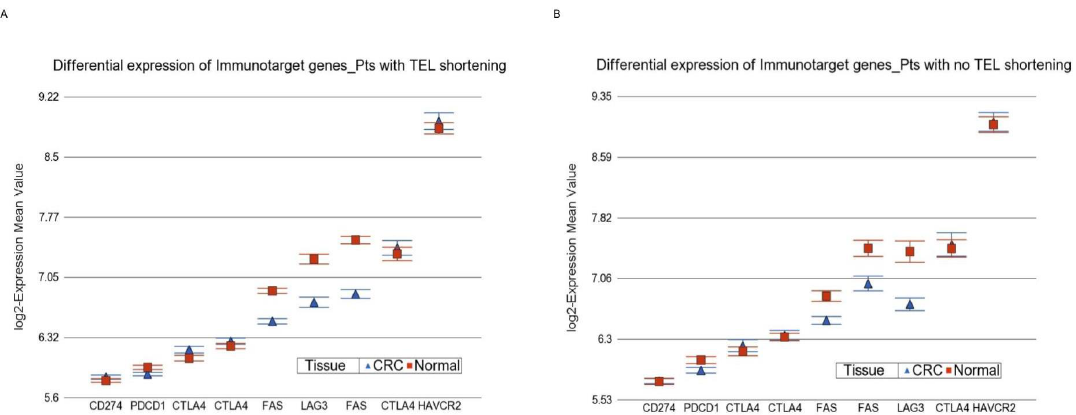
Figure 9. Immune checkpoint inhibitors (ICIs) are targeted to certain immunotarget genes. Differ- ential expression of those immunotarget genes in CRC tissue (in blue) compared to corresponding normal tissue (in red) is shown. Data from patients with RTL shortening are shown on the left ( A ), and data from patients without RTL shortening are shown on the right ( B ). The magnitude of differential expression was similar in patients with or without RTL shortening.